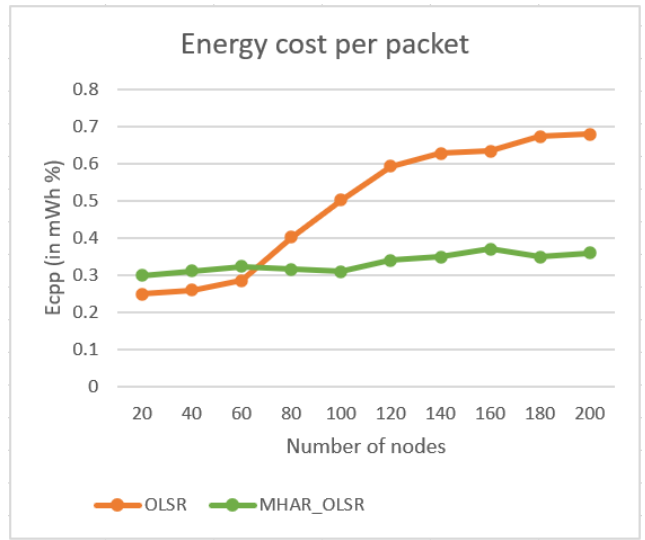
Figure 13. Energy cost per packet as function of